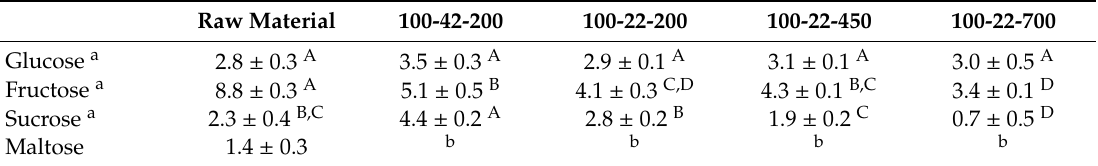
Table A3. Contents of free mono- and disaccharides (g / 100 g dry matter) of raw and extruded apple pomace (mean value ± standard deviation, n = 3).